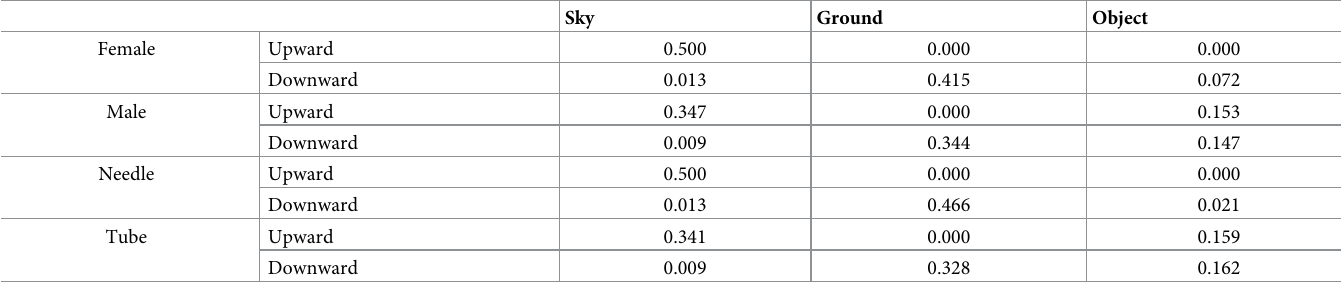
Table 1. Detailed values of view factors ( F ) for heat budget calculation.